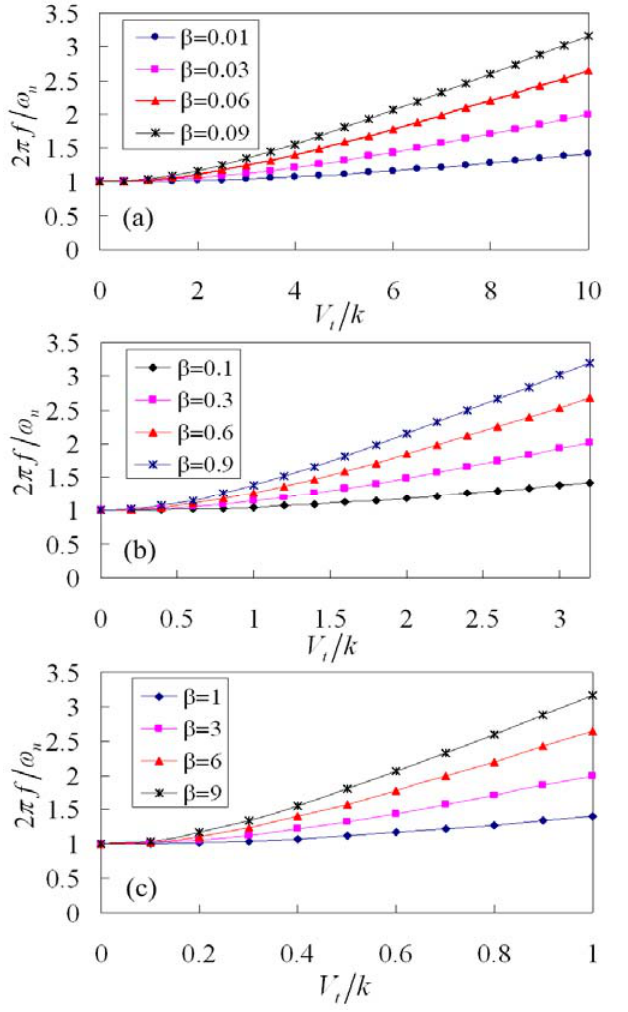
Figure 6. Frequency ratio of the tunable resonator with different shape